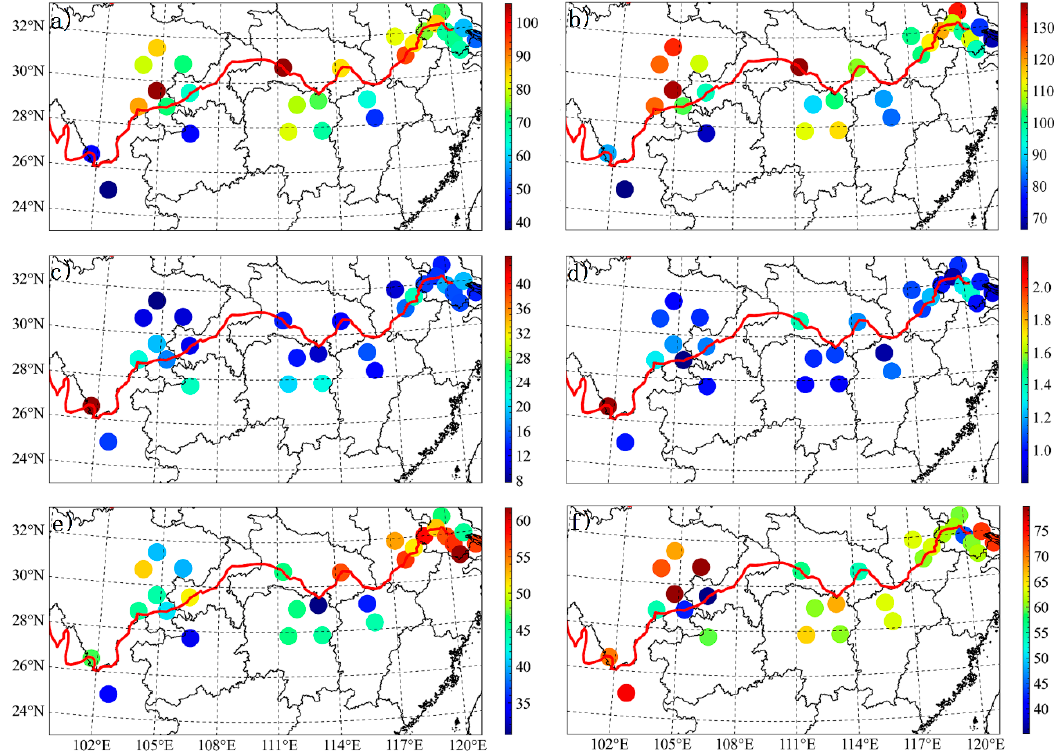
Figure 2. Wintertime average concentrations of particle matter (PM) 2.5 ( a ), PM 10 ( b ), SO 2 ( c ), CO ( d ), NO 2 ( e ), and 8-h peak O 3 ( f ). The unit is µg/m 3 for PM 2.5 , PM 10 , SO 2 , NO 2 , 8-h peak O 3 , and mg/m 3 for the CO.